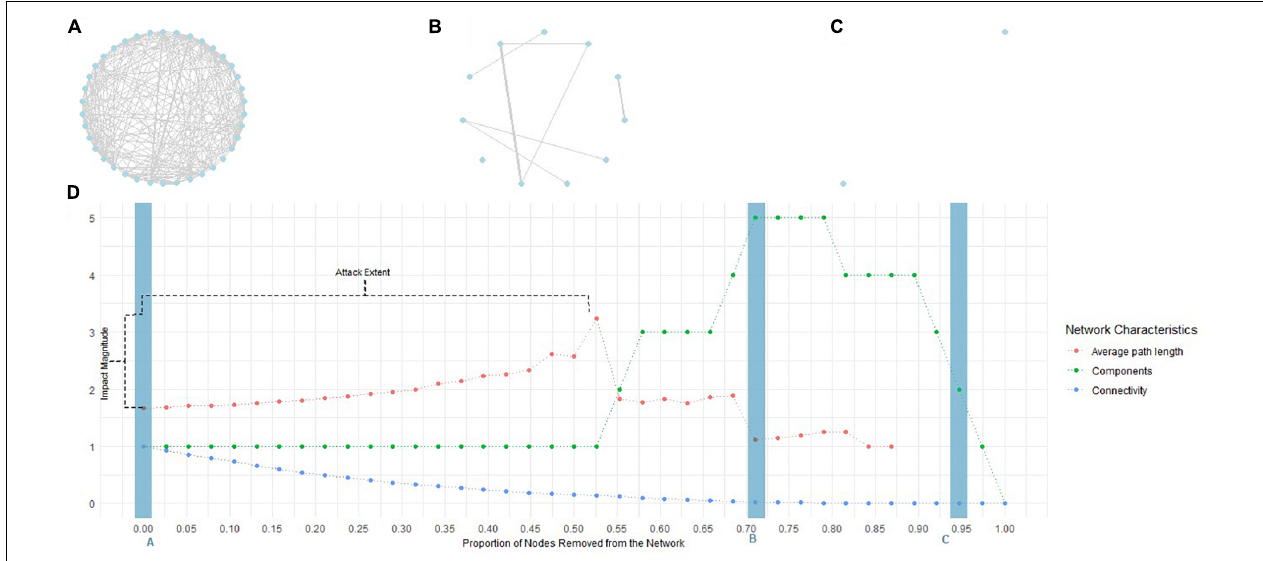
FIGURE 1 | Illustrative example of network attack. Symptom networks are usually represented in a graph comprised of nodes representing symptoms (blue circles in A–C ) and edges representing the interactions between symptoms (gray lines in A–C ; line width represents the strength of the interaction). The complete graph represents the causal structure of the interactions between the symptoms. Its exploration provides information regarding the centrality of diverse symptoms (e.g., the number of interactions with other symptoms), as well as the network characteristics (e.g., the number of symptoms, or groups of symptoms, disconnected from the remainder). (A) Represents the original psychopathological network. Under attack, the symptoms (nodes) were sequentially removed, one at a time, in the decreasing order of two centrality measures – (1) degree and (2) strength – and two bridging measures – (3) bridgeness and (4) overlap. (B,C) Represent the evolution of the initial network as symptoms are removed. At each point, network characteristics were measured (average path length, number of components, connectivity, and diameter). The evolution of these measures throughout the attack is represented in (D) . The blue rectangles signal the moments to which the networks represented in (A–C) correspond. Finally, the attack extent and the magnitude of its impact were measured considering the number of symptoms that had to be removed to achieve peak average path length, number of components, connectivity, and diameter, as well as the difference between peak and initial